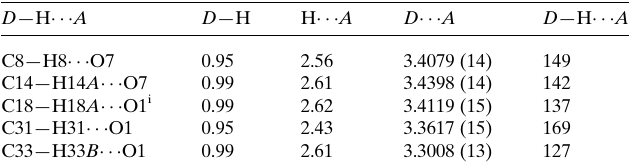
Table 1 Hydrogen-bond geometry (A˚ , (cid:2) ).